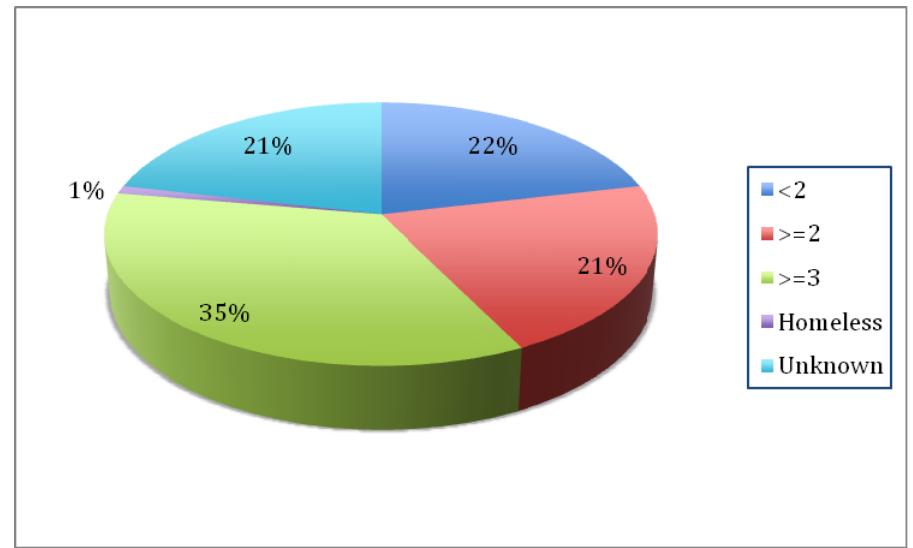
Housing: number of